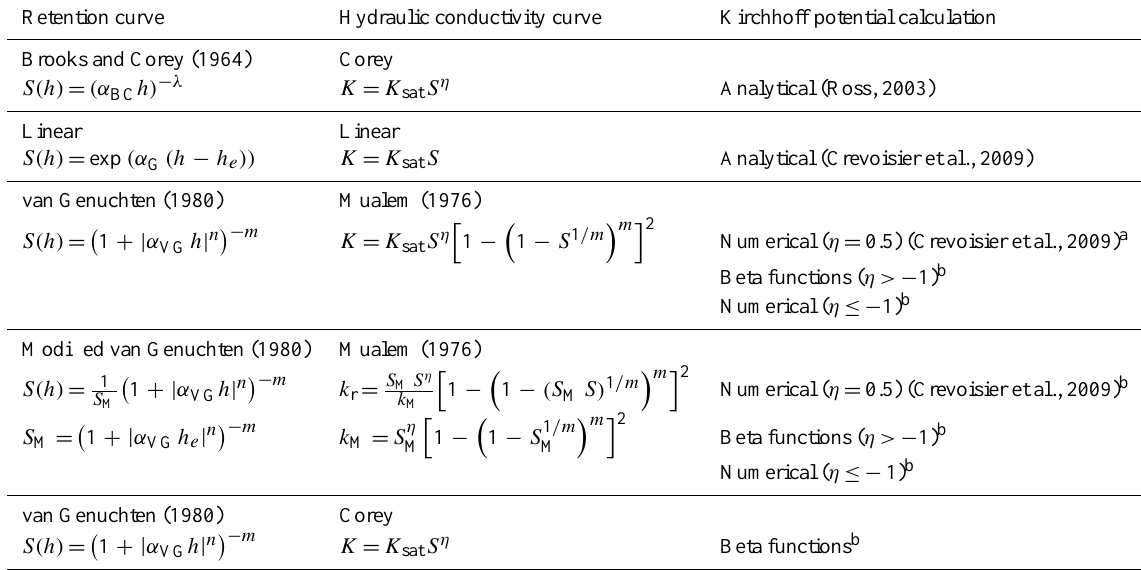
Table 1. Hydraulic property curves available in the FHAVeT and Kirchhoff potential calculation